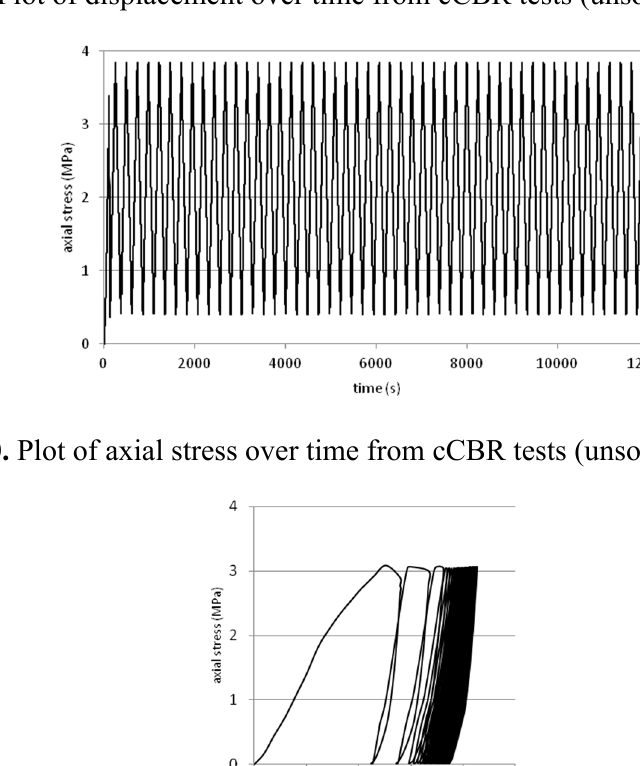
Figure 9. Plot of displacement over time from cCBR tests (unsoaked conditions).